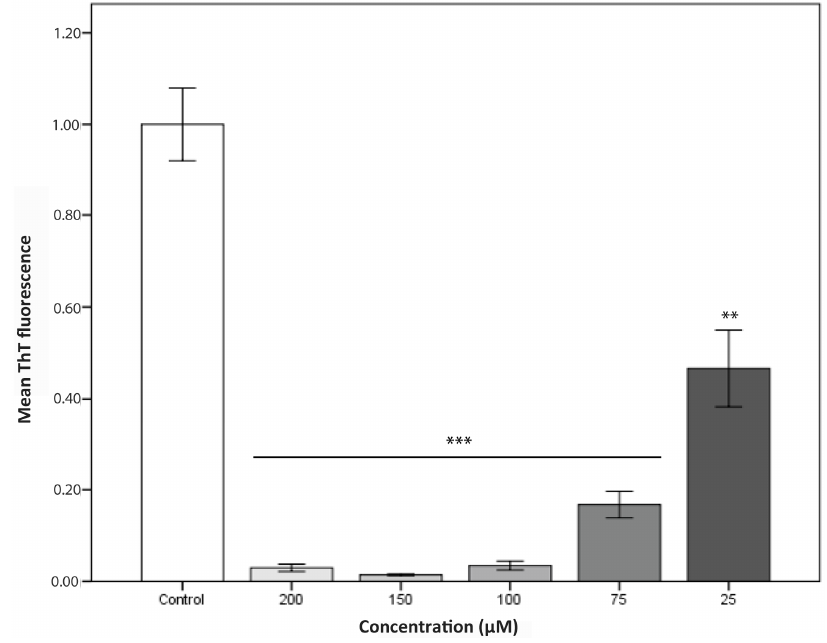
Figure 5. Inhibition of α -synuclein aggregation at different concentrations of the compound D. Error bars are represented as standard error, where p < 0.005 and p < 0.0005 were indicated by ** and *** respectively.